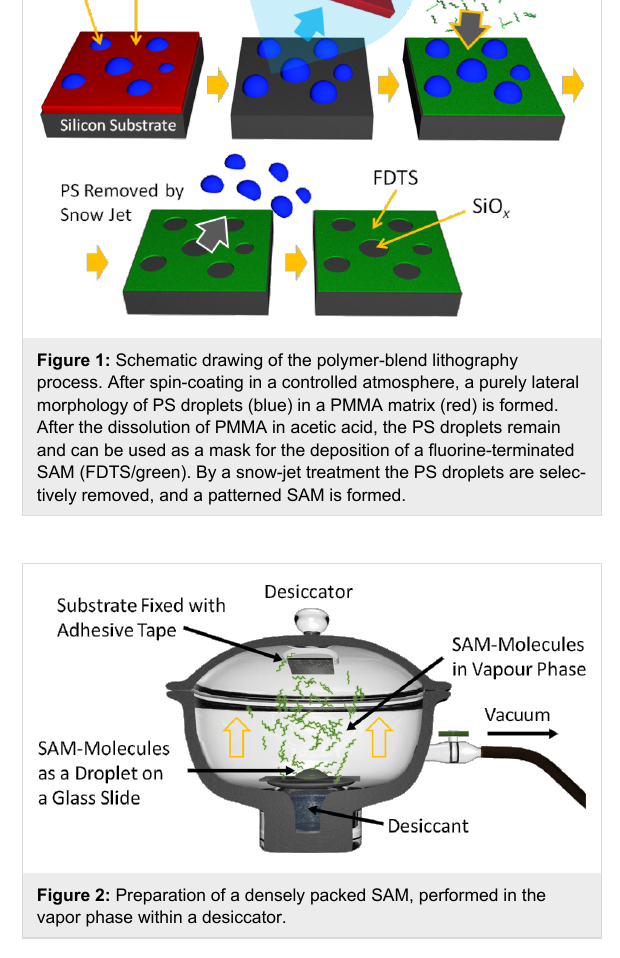
of molecules used. By the choice of the SAM molecules the desired chemical surface functionality (functional group) can be